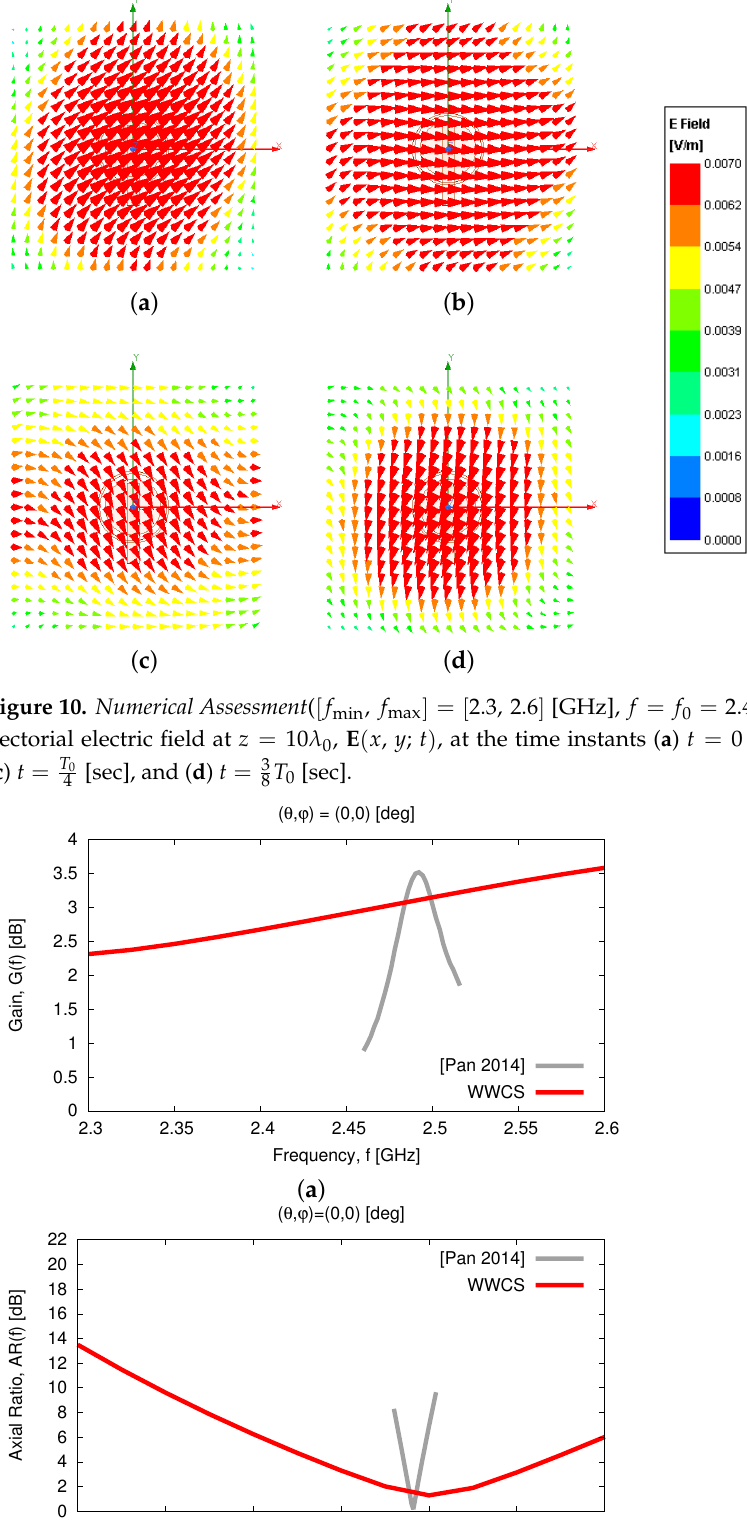
Figure 11. Numerical Assessment ( [ f min , f max ] = [ 2.3, 2.6 ] [GHz])—Behavior of the ( a ) broadside gain, G ( f , θ = 0, ϕ = 0 ) , and ( b ) axial ratio, AR ( f , θ = 0, ϕ = 0 ) , as compared to the literature result in